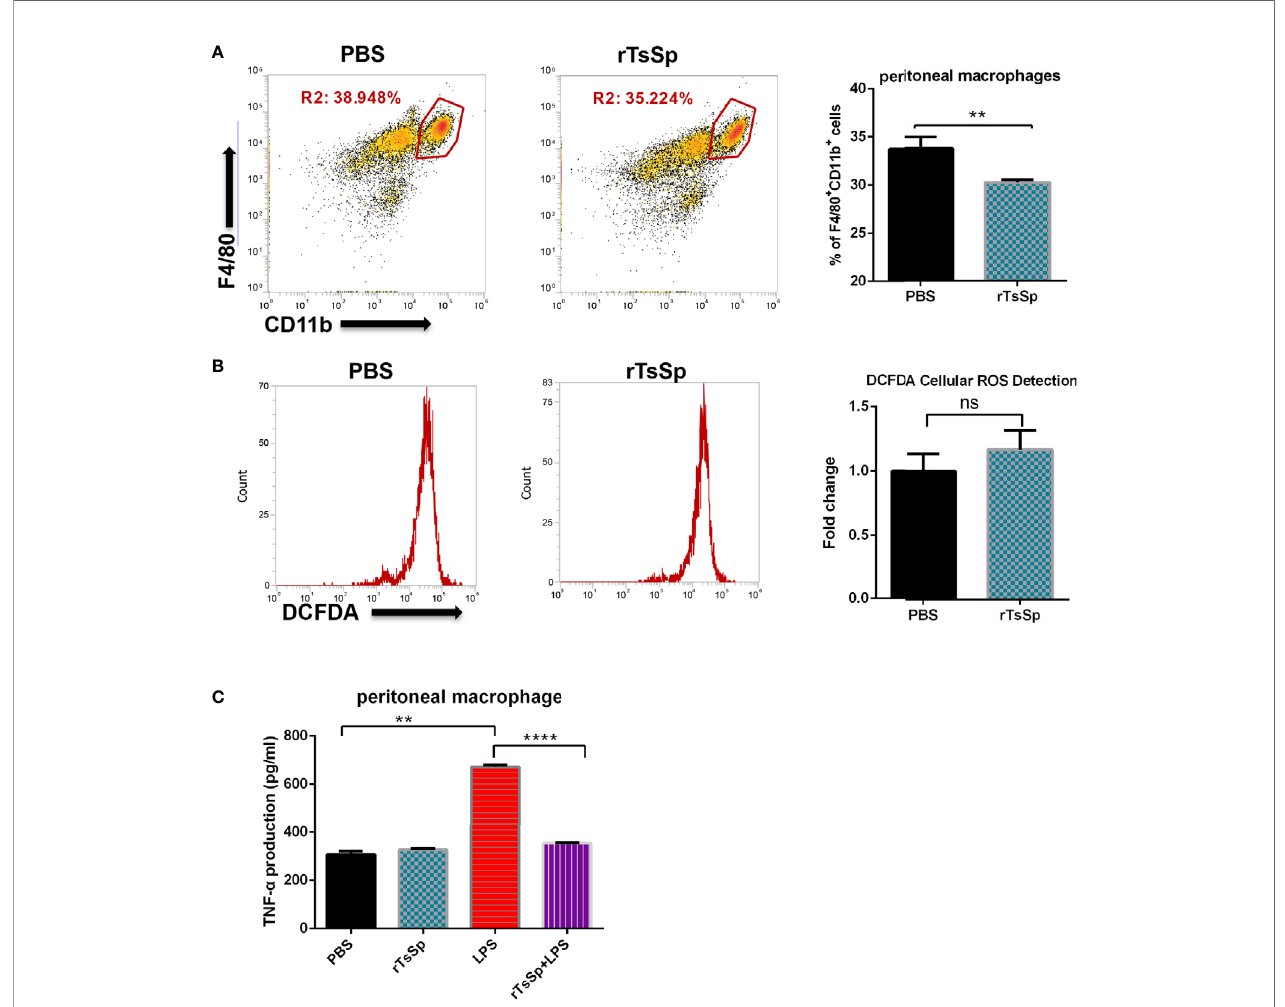
FIGURE 6 | The effect of rTsSp on peritoneal macrophage population, ROS and TNF- a production. (A) Peritoneal macrophages were isolated from wild type and rTsSp pre-treated mice, identi fi ed with anti-F4/80 and CD11b mAb. (B) Intracellular ROS production was measured using the DCFDA. The stained samples were analyzed with BD FACSCanto. Results are expressed as fold change of mean fl uorescent intensity after background subtraction between control and treated cells. (C) Immunization with rTsSp results in suppression of the TNF- a production by peritoneal macrophages. Peritoneal macrophages were isolated from PBS control and rTsSp-immunized mice and stimulated with LPS/PBS. The data shown are means ± SEM from one of three separate experiments performed showing similar results. ** P < 0.01; **** P < 0.0001; ns, no signi fi